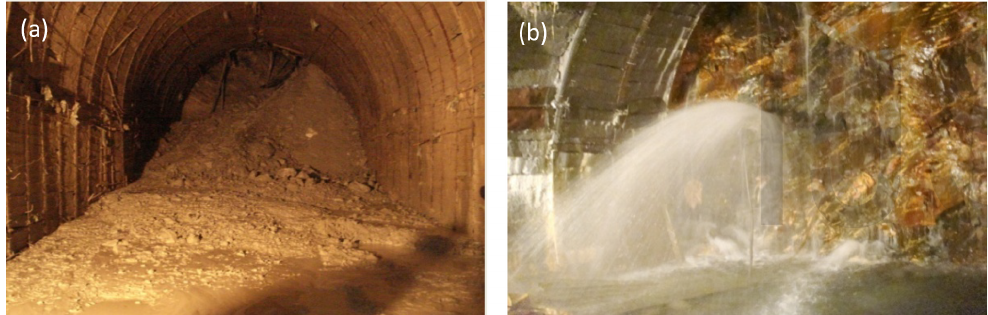
Figure 12. ( a ) Mud and debris flows, ( b ) high pressure water inrush encountered in the KHP (Source: Alam and Sharma